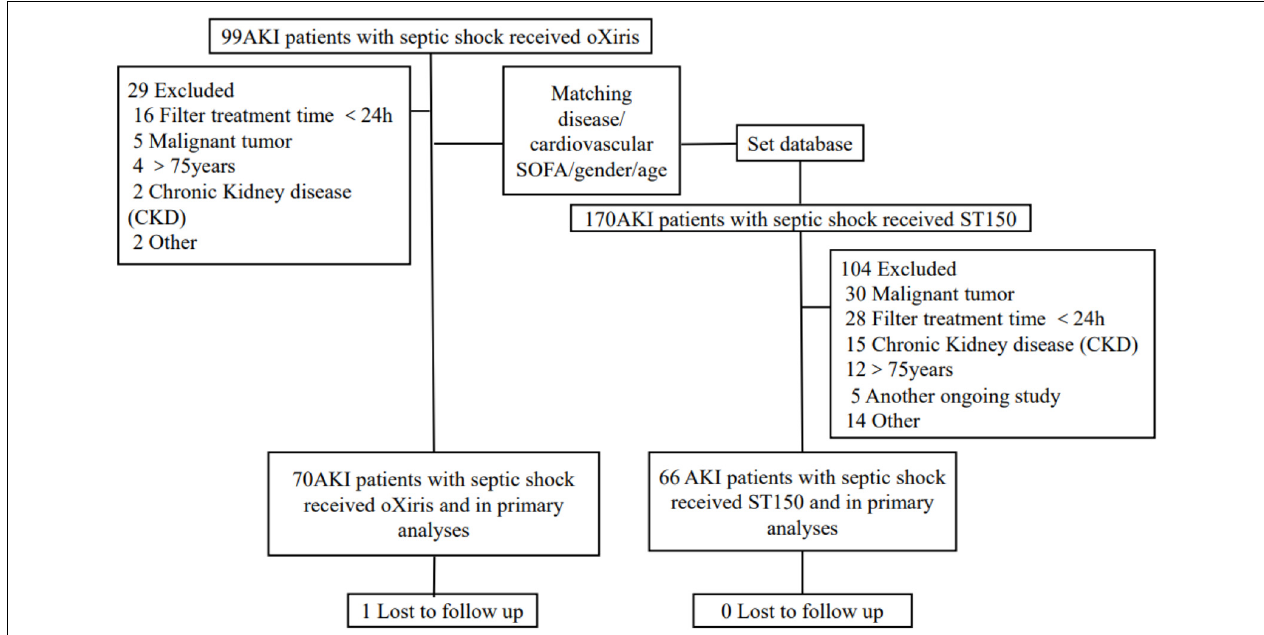
FIGURE 1 | Patient recruitment, and flow of the study. AKI, acute kidney injure; SOFA, sequential organ failure assessment.